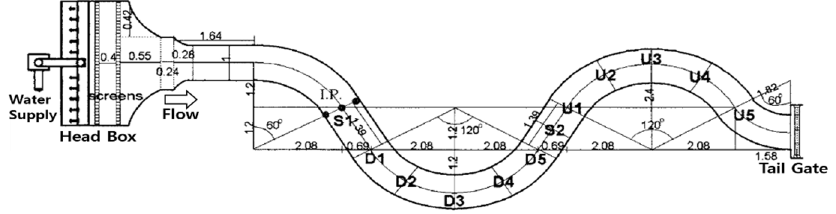
Figure 3. Plan view of small-scale meandering channel in laboratory (adapted from Baek et al. [3]).